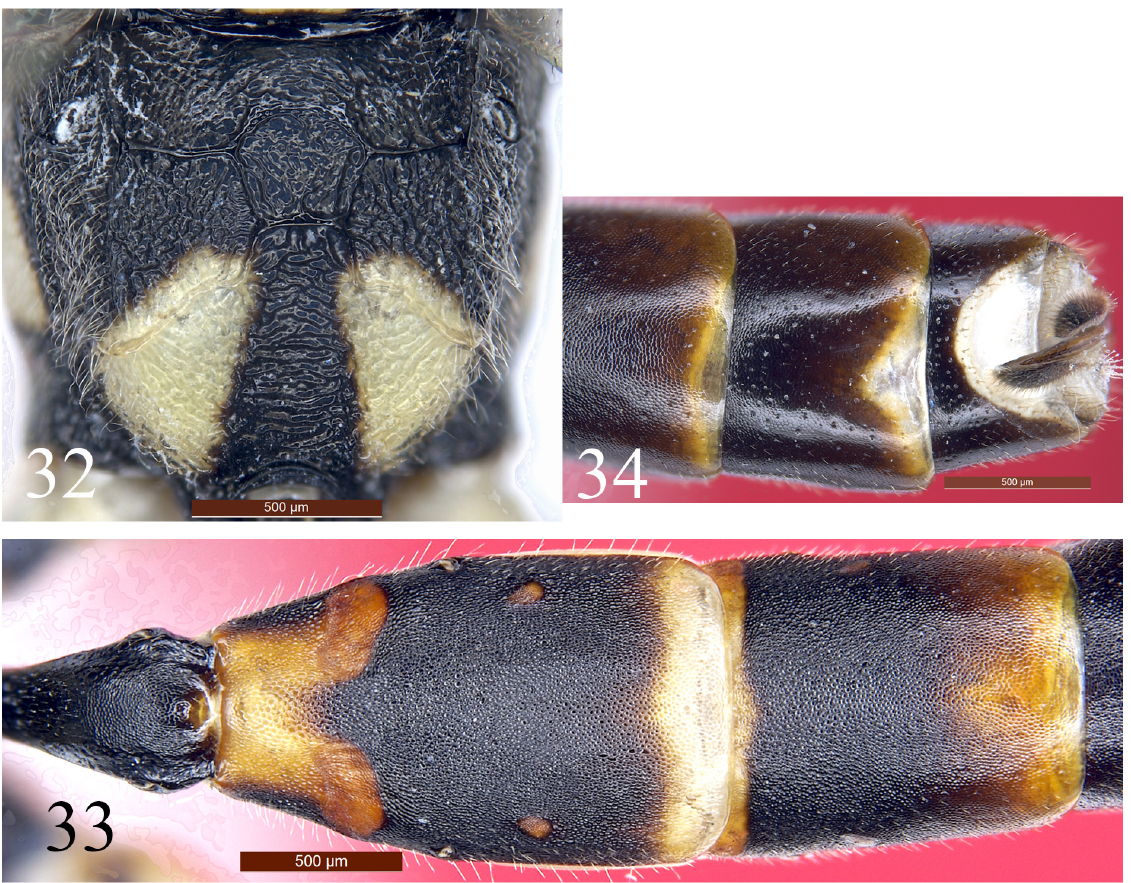
Figs 32–34. Notosemus wugongicus Sheng & Sun, sp. nov., holotype, ♀. 32 . Propodeum. 33 . Tergites 1–3, dorsal view. 34 . apical portion of metasoma,